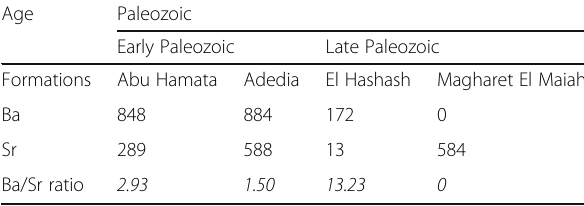
Table 9 Br/Sr ratio of studied Paleozoic